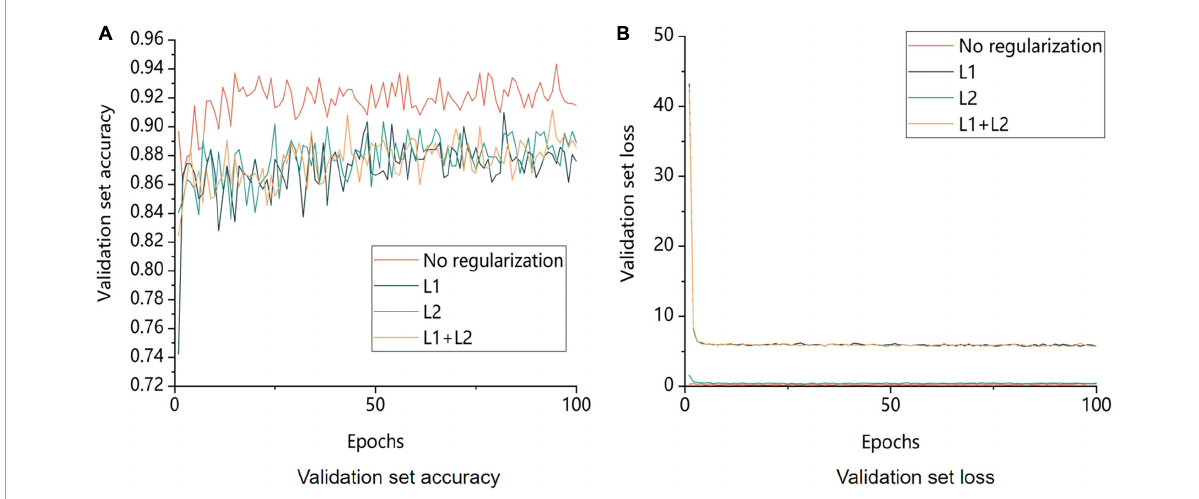
FIGURE11 Comparison of validation set accuracy and model loss for different regularization strategies. No regularization is not regularization, L1 is using L1 regularization, L2 is using L2 regularization, L1+L2 is both L1 and L2 regularization being used. A is the image of the change in accuracy of the validation set and B is the image of the change in loss value of the validation.